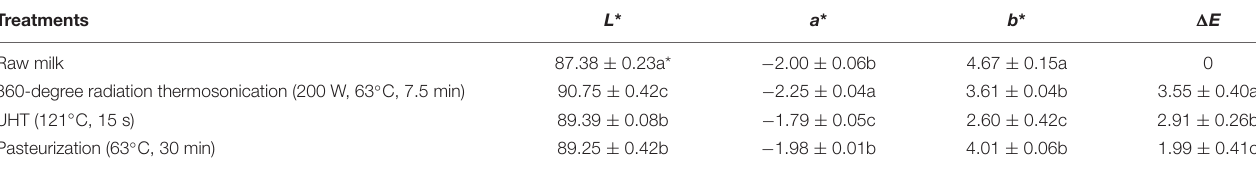
TABLE 5 | The color changes of milk before and after various treatments. Treatments L